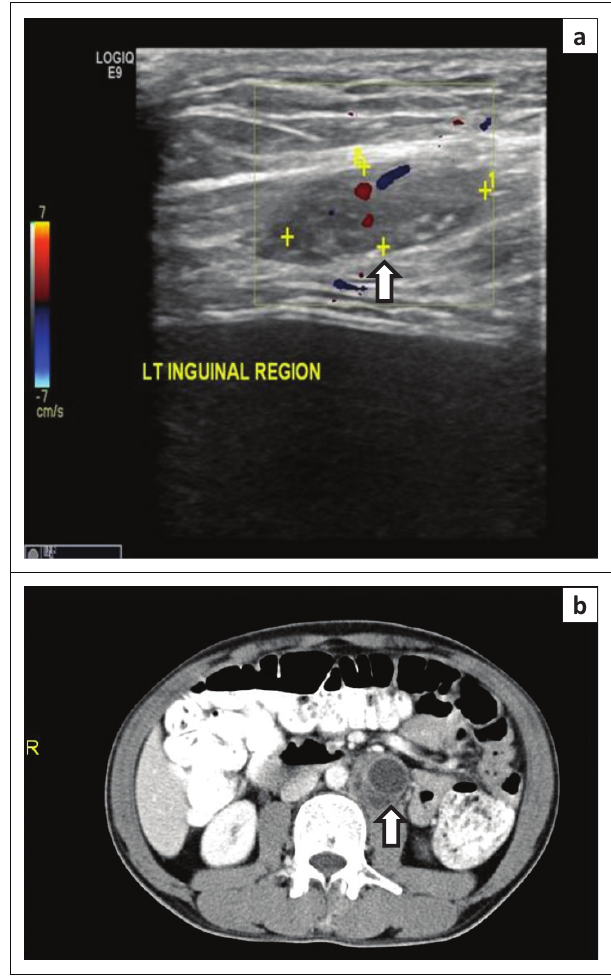
FIGURE 8: Coronal non-contrast computed tomography abdomen of a 35-year- old male who presented to the emergency department with right flank pain.